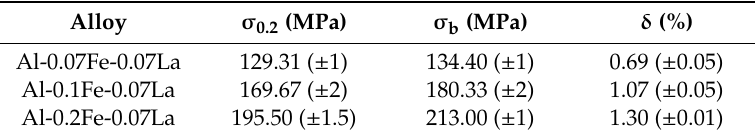
Table 1. Tensile strength of the aluminum alloy foils.